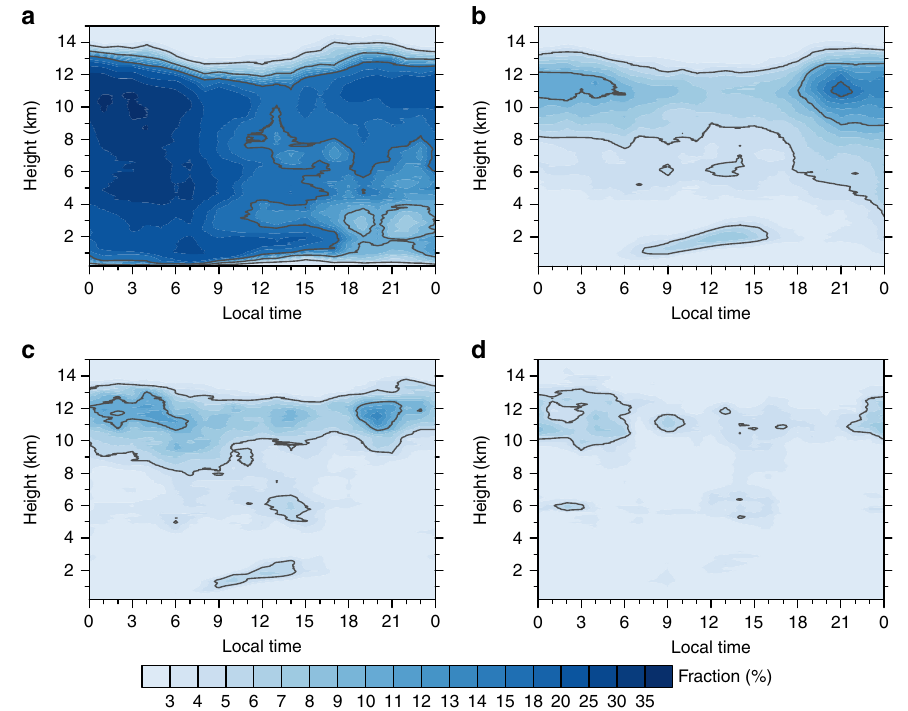
Fig. 4 Composite diurnal variations of cloud fraction. a Diurnal cycle of cloud fraction averaged over precipitating days, b non-precipitating days, c fi ve consecutive non-precipitating days under wet precondition, and d fi ve consecutive non-precipitating days under dry precondition. The sample sizes are 288, 945, 49, and 73, respectively. Contours indicate 5, 10, and 15% cloud fraction